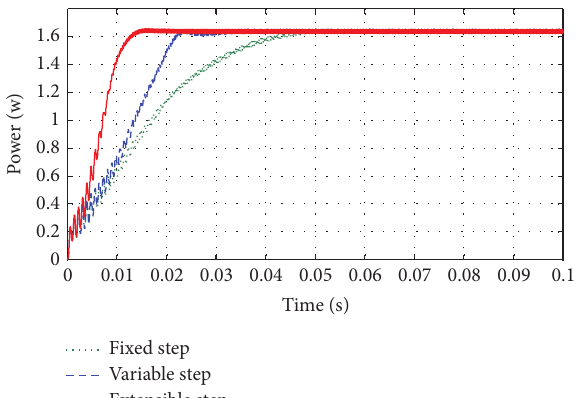
Figure 3: Comparison result of FICM, VICM, and EICM.